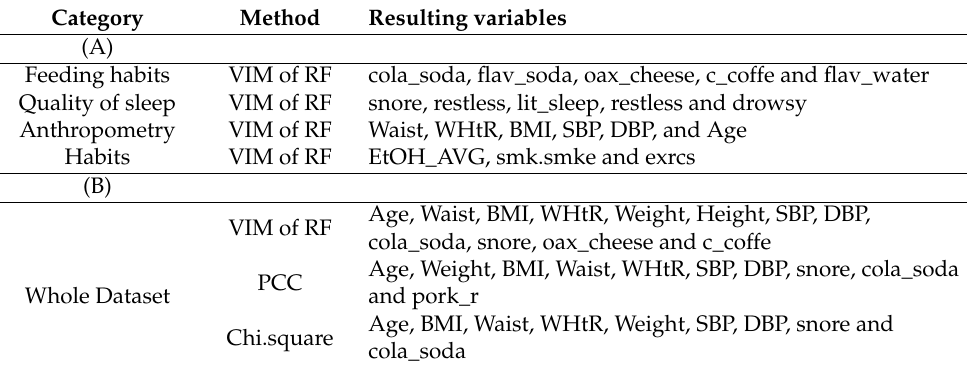
Table 1. (A) Most important variables in women by category. (B) Most important variables in women in whole dataset.